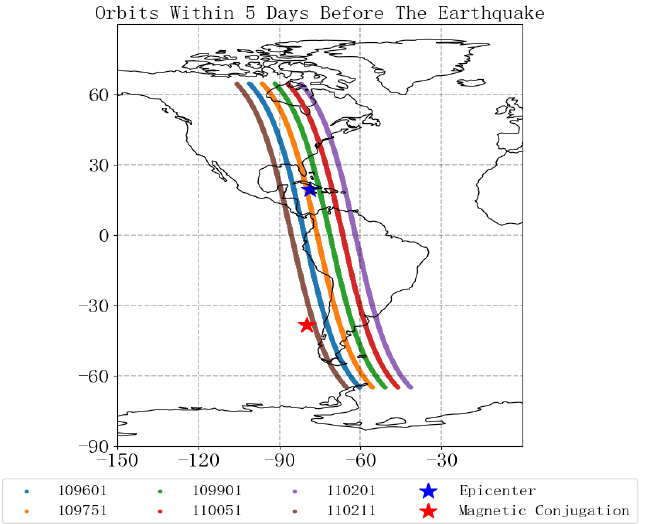
Figure 1. Satellite trajectory projection within 5 days before the earthquake (the blue star is the epicenter, the red is the epicenter magnetic conjugate point).